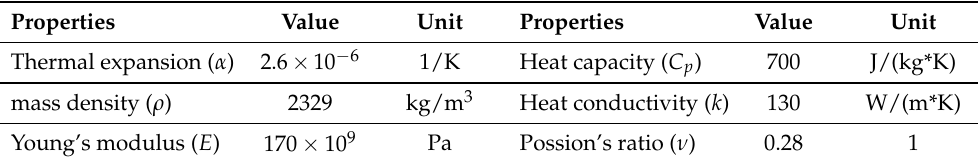
Figure 13. The overall design of the accelerometer. Table 1. Silicon properties for simulation.